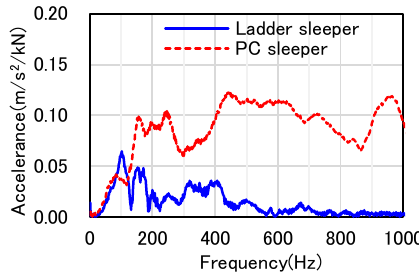
Figure 6. Comparison of the accelerance.